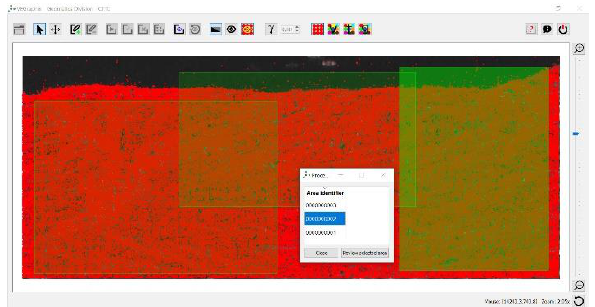
Figure 7: Revisiting areas that have already been processed. Final merging: The local reprocessing steps described